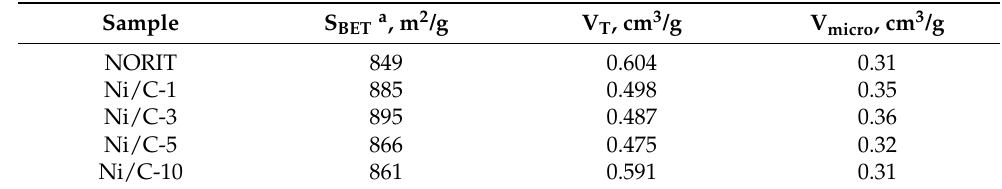
Table 1. Surface area and pore volume of the composites and NORIT activated carbon calculated from N 2 adsorption at 77 K.